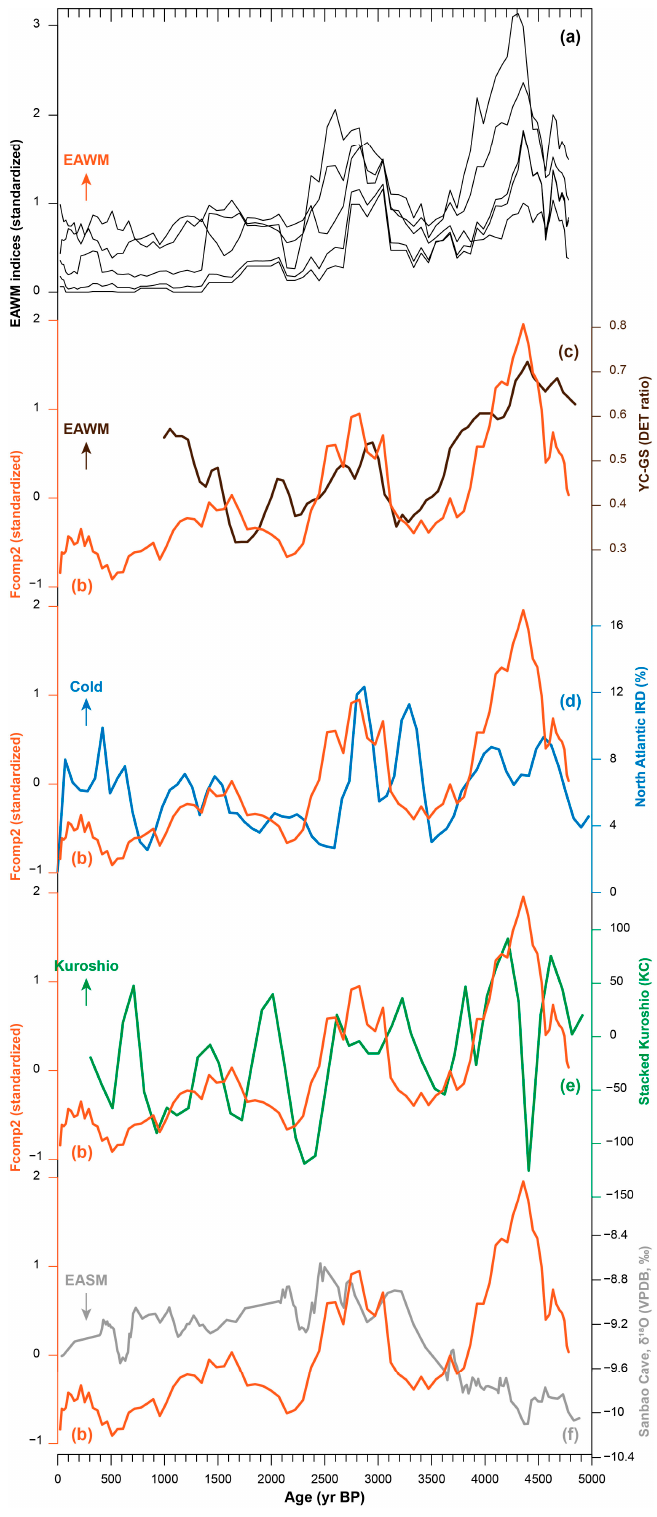
Figure 5. Comparison between various paleoenvironmental proxies over the past 5000 years. ( a ) 5-point moving average of five grain-size parameters of core ECS-DZ1; ( b ) Fcom2 record of core ECS-DZ1 indicating changes in the winter monsoon; ( c ) DET YS-GS index, indicating winter dust storms in Central Asia [40]; ( d ) ice-rafting debris (IRD), stack ice-rafting debris data from Bond, et al. [41]; ( e ) Stack KC, integrated indicator from four time series [42]; ( f ) Stalagmite δ 18O series of Sanbao Cave [43], indicating East Asian summer monsoon (EASM) intensity.